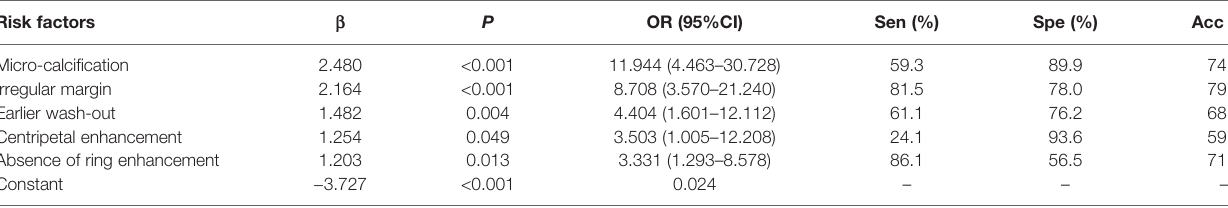
TABLE 3 | Multivariate analysis of the risk factors for malignancy in the derivation cohort. Risk